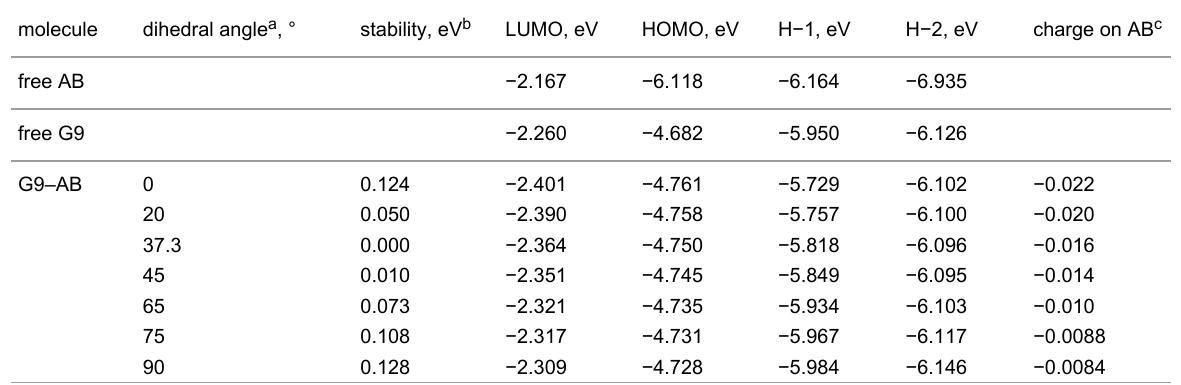
Table 1: Orbital energies for G9, azobenzene (AB) and G9–AB.